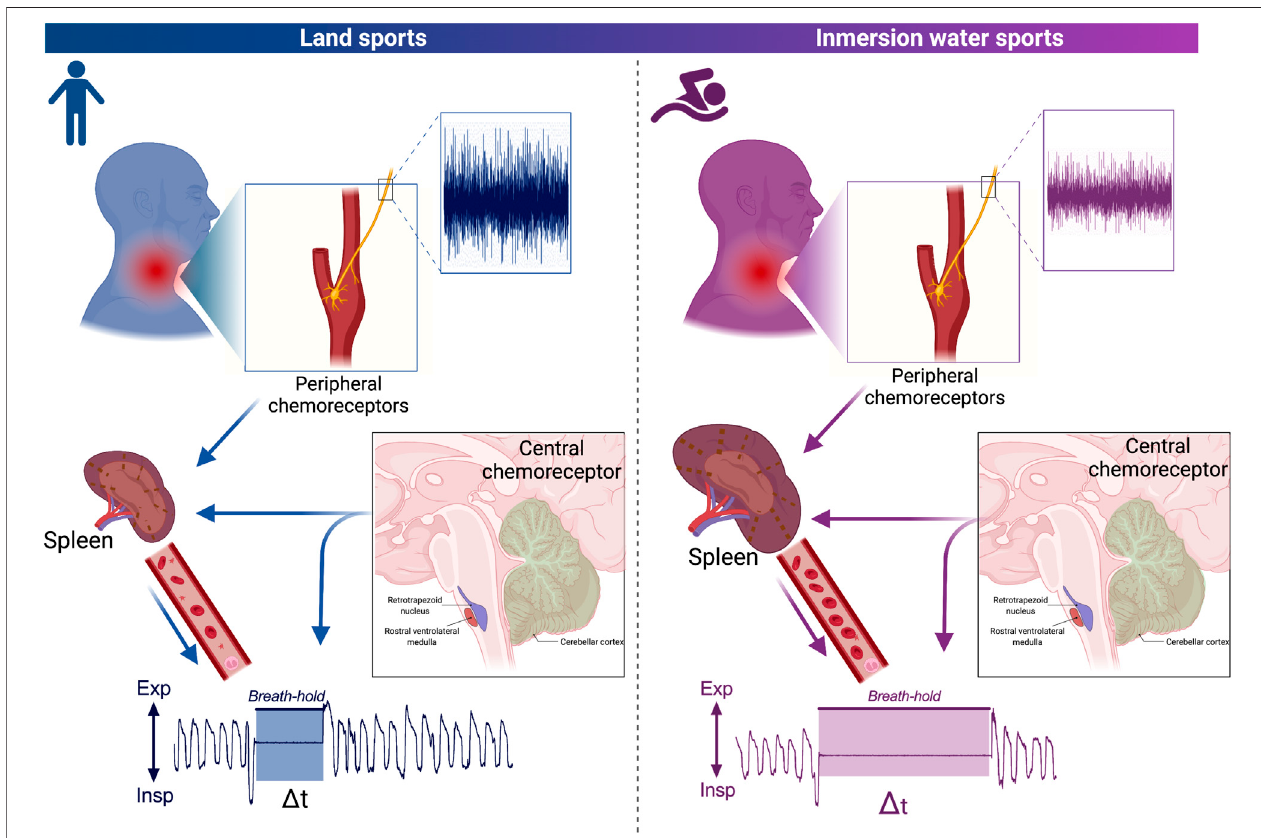
FIGURE2| Hypotheticalschematicrepresentationmodelrelatedtothein fl uenceofthecentralandperipheralchemore fl exonabreathhold.Peripheralandcentral chemore fl ex responses of land sports athletes and immersion water sports athletes (left and right, respectively). Carotid body peripheral chemoreceptors send afferences to the nucleus of tractus solitary (NTS) in response to decreases of arterial O 2 (hypoxia). Accordingly, the NTS project to the central pattern generator (CPG), which is able to produce hyperventilation. In addition, activation of peripheral and central chemoreceptors increases sympathetic activity, producingcontraction of the spleen which releases oxygenated blood into the bloodstream. Note that adaptations in immersion athletes involve desensitization of peripheral chemoreceptors which possibly decreases input to NTS and thus to CPG, as well as an increase in size and storage of oxygenated blood in the spleen which allows greater release of blood into the systemic circulation increasing the time of apnea. Nevertheless, apparently central chemoreceptors do not have greater relevance in the breath-hold.